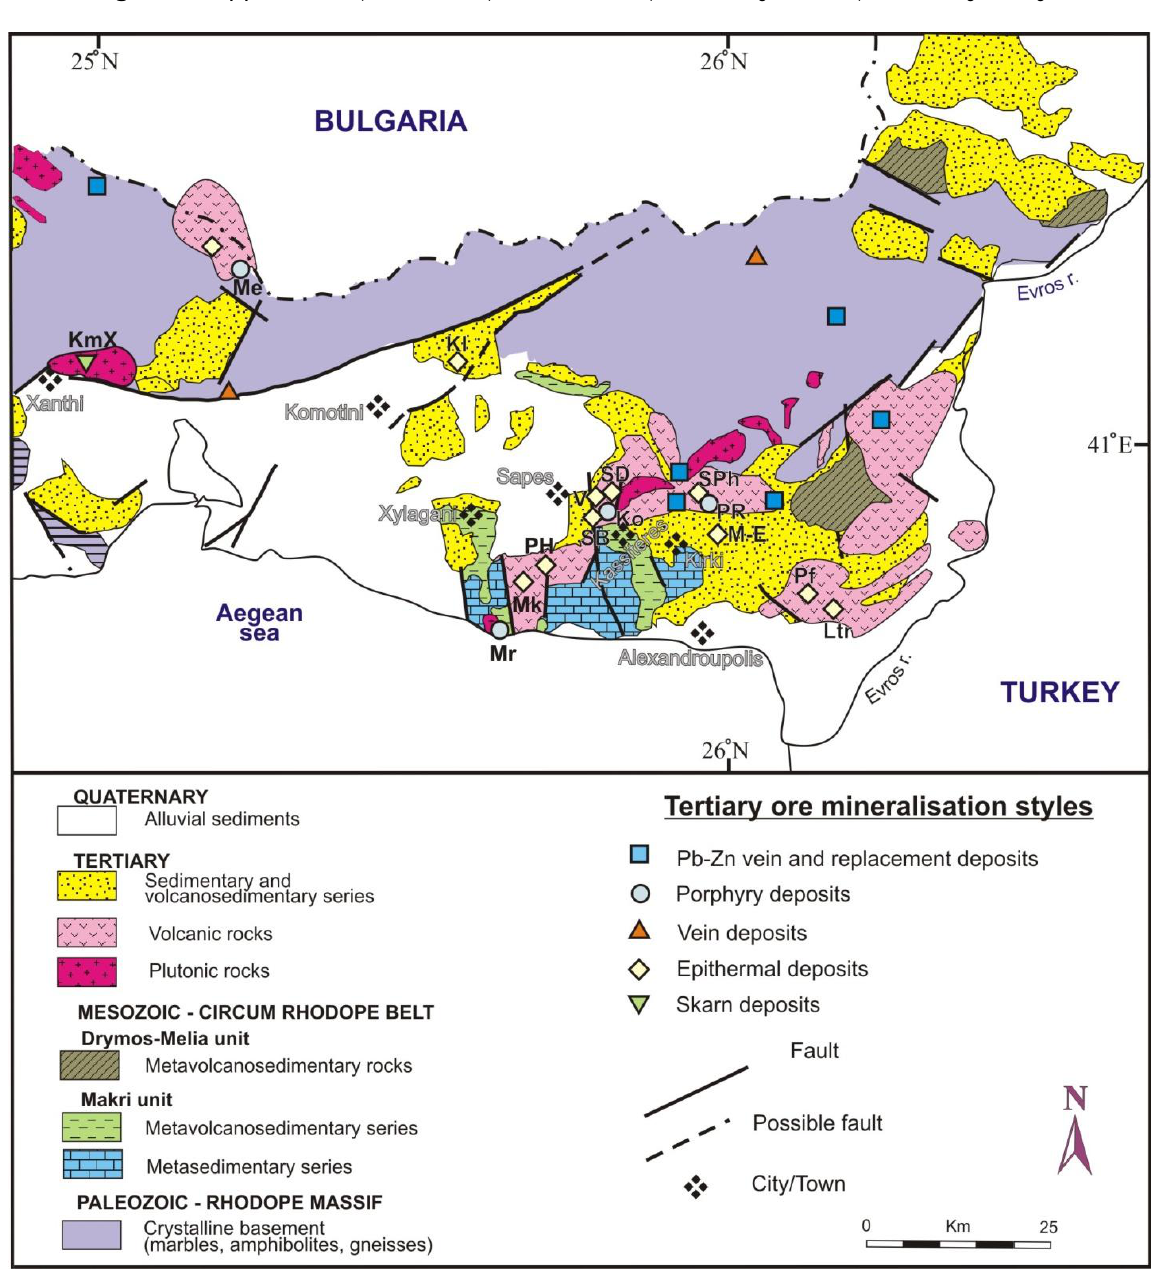
Figure 3. Simplified geological map of the Rhodope metallogenic province in Greece displaying the major Tertiary ore deposits and prospects [6,7 with modifications]. KmX: Kimmeria/Xanthi; Me: Melitena; Mr: Maronia; Ko: Konos/Sapes; SB: St. Barbara/Kassiteres; SD: St. Demetrios/Sapes; V: Viper; PH: Perama Hill; Mk: Mavrokoryfi; PR: Pagoni Rachi/Kirki; SPh: Agios Philippos/Kirki; Pf: Pefka; Ltr: Loutros; Kl: Kallyntirion; M-E: